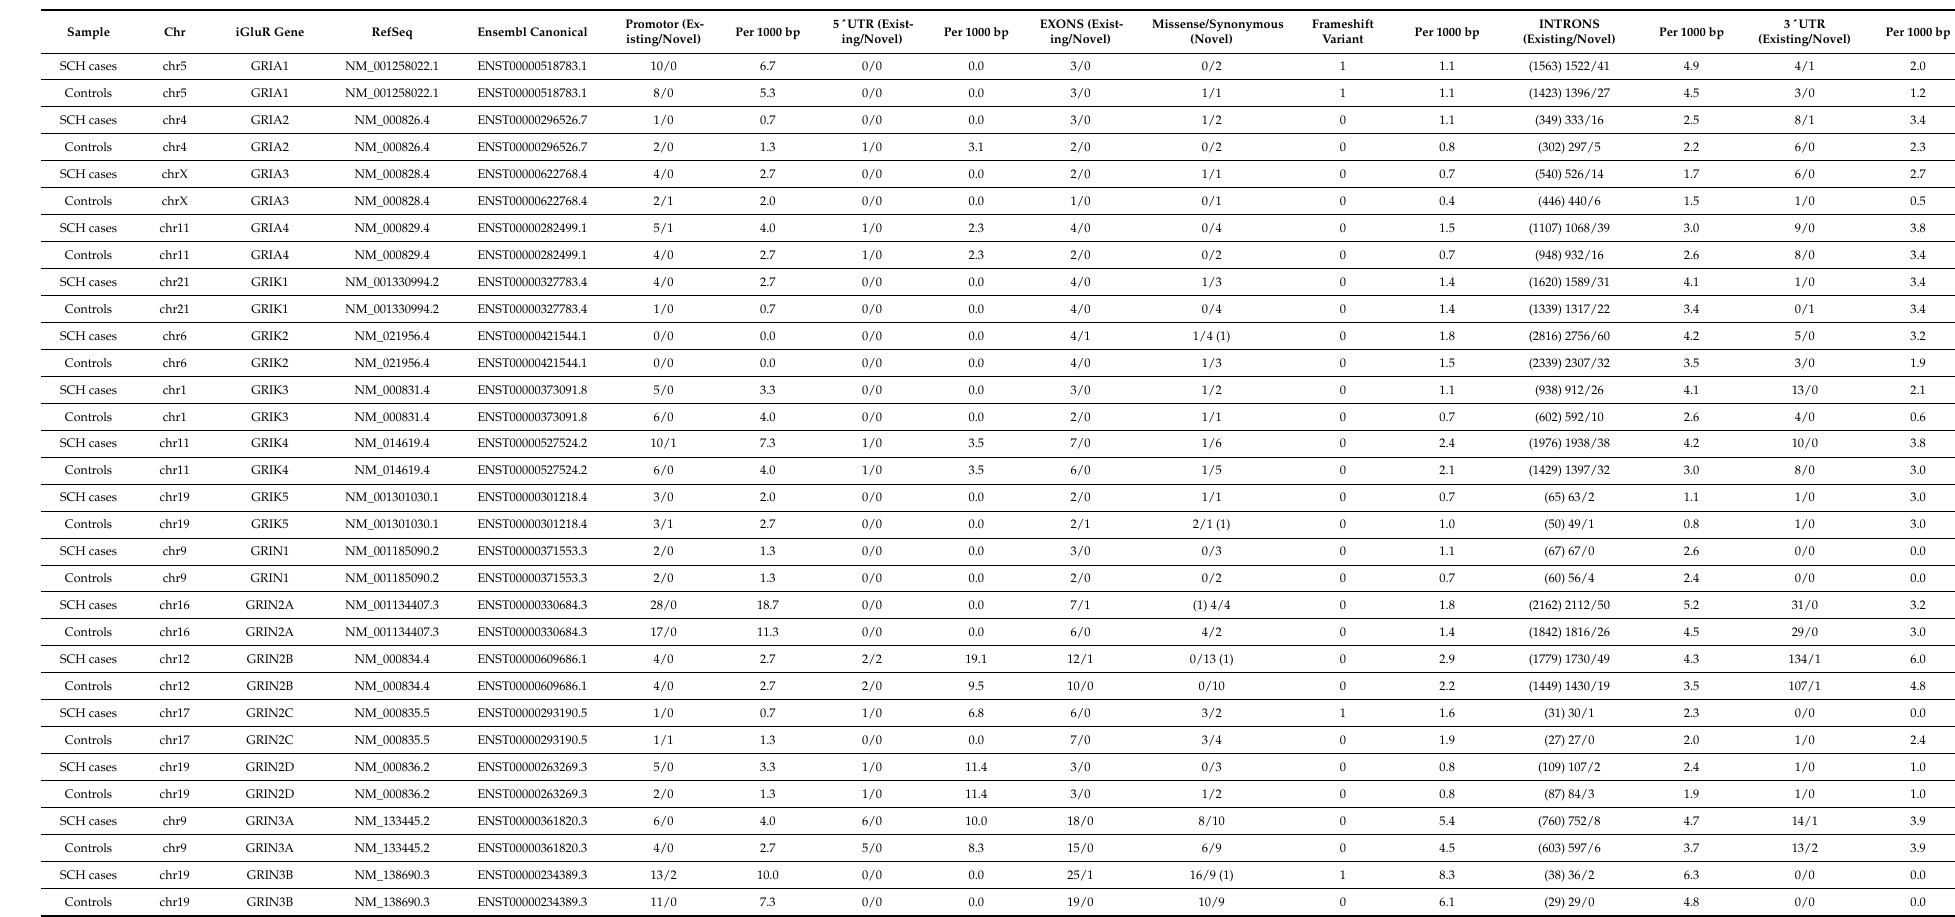
Table 2. Genetic variations of iGluR genes. The summary of detected genetic variations within the promoter regions (1500 bp upstream of a TSS), 5 (cid:48) UTRs, exons, introns, and 3 (cid:48) UTRs of sixteen iGluR genes. The rate of variation in specific parts of the genes is expressed as the frequency of variants per 1000 bp. The RefSeq transcript corresponds to the canonical Ensembl transcript. Note: the RefSeq transcript does not necessarily have to be a canonical transcript itself in the hg38 assembly